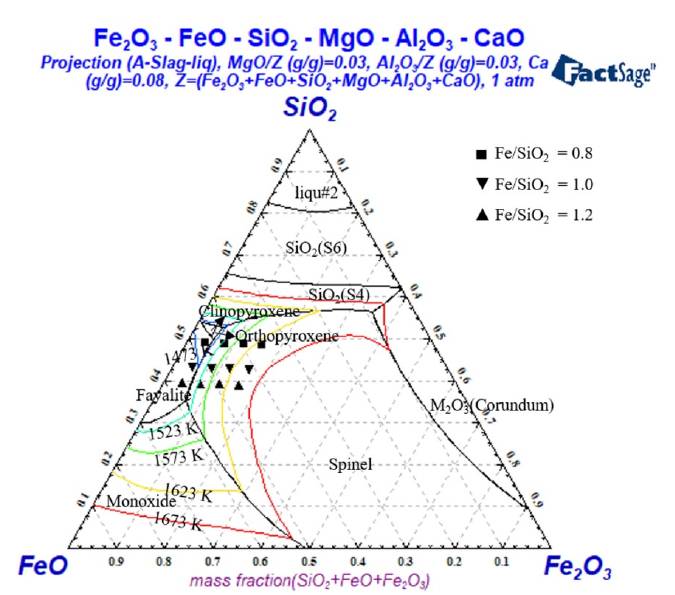
Figure 10. Phase diagram of FeO − Fe 2 O 3 − SiO 2 − 8 wt% CaO − 3 wt% MgO − 3 wt% Al 2 O 3 slag system